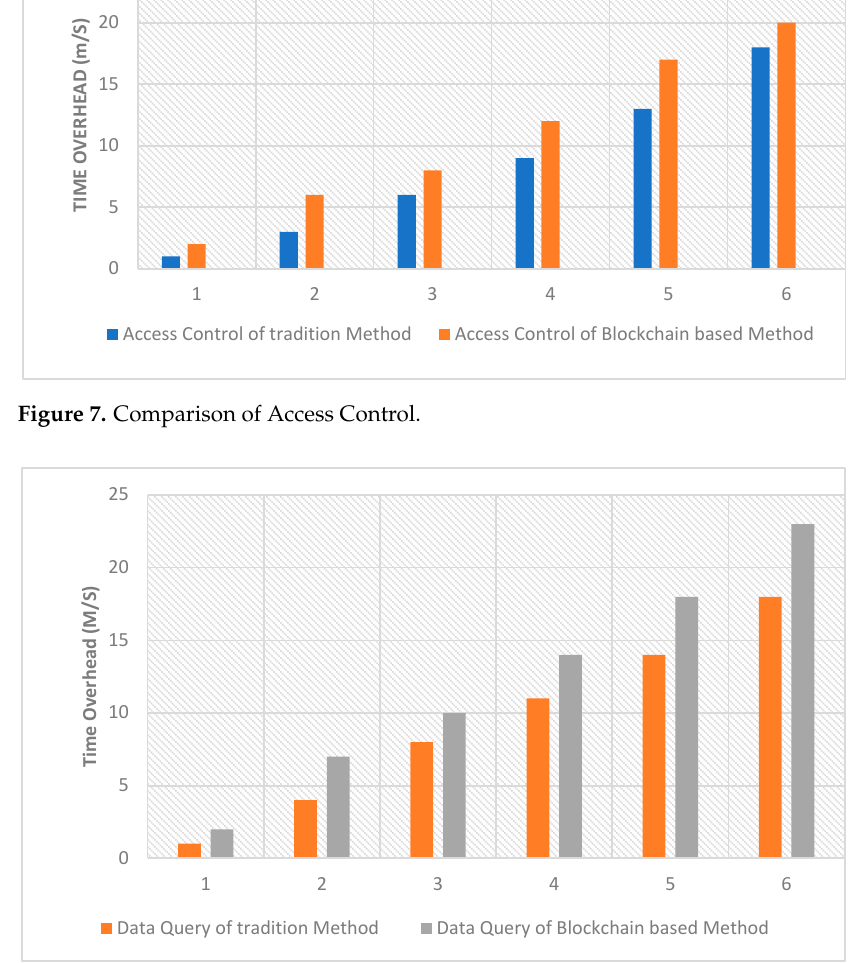
Figure 8. Comparison of Data Query .